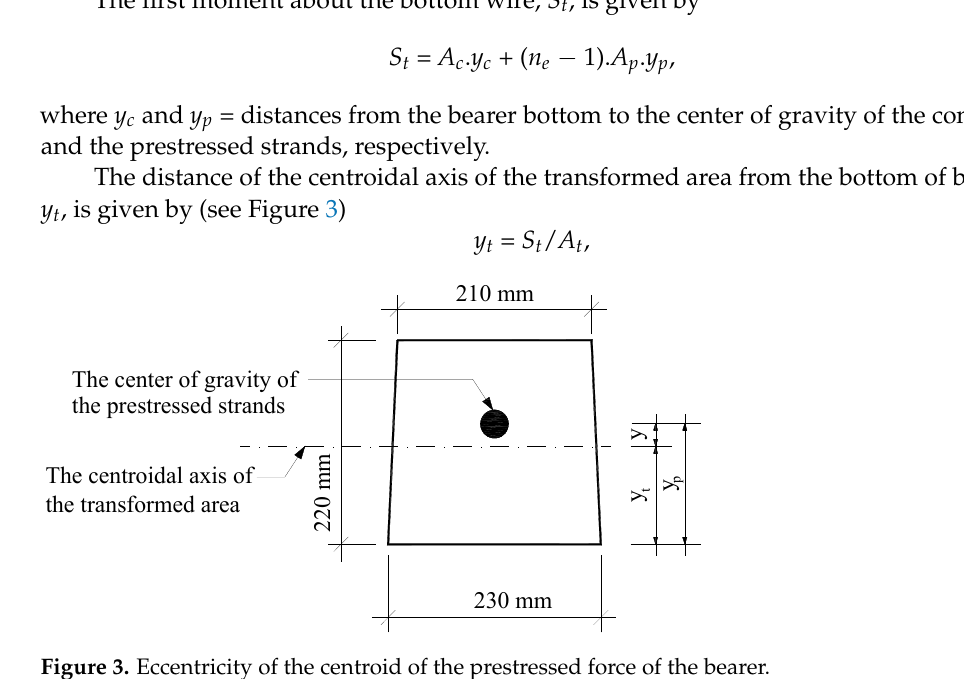
Table 1. Variables and dimensions of the bearer cross-section.